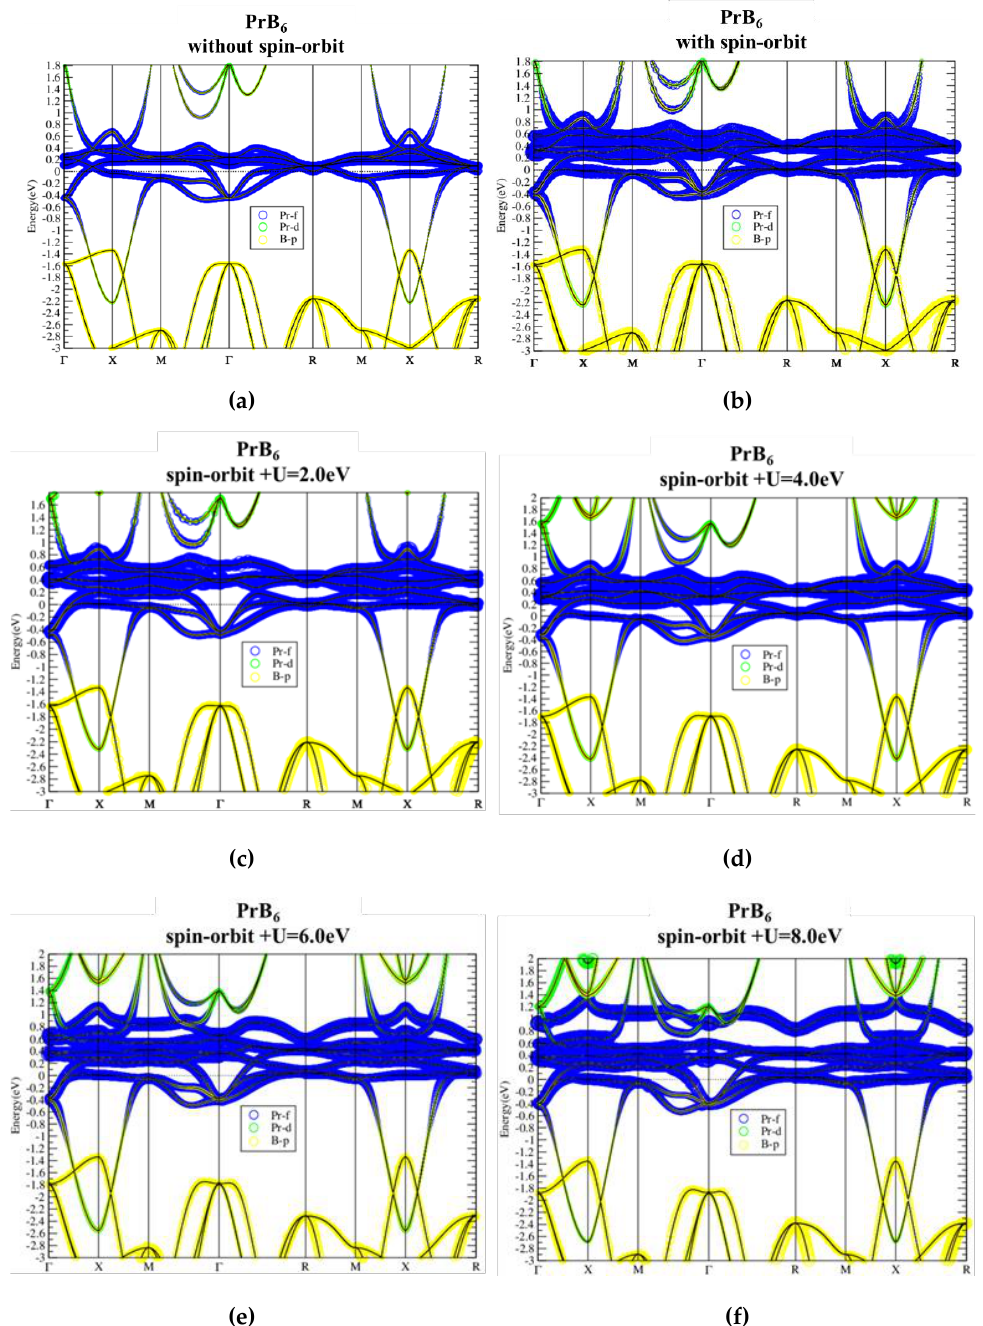
Figure 6. PrB 6 band structure without ( a ) and with ( b ) spin–orbit interaction (noted in the figures), and with spin–orbit interaction plus on-site U = 2, 4, 6, 8 eV ( c – f , respectively) as noted in the figures.